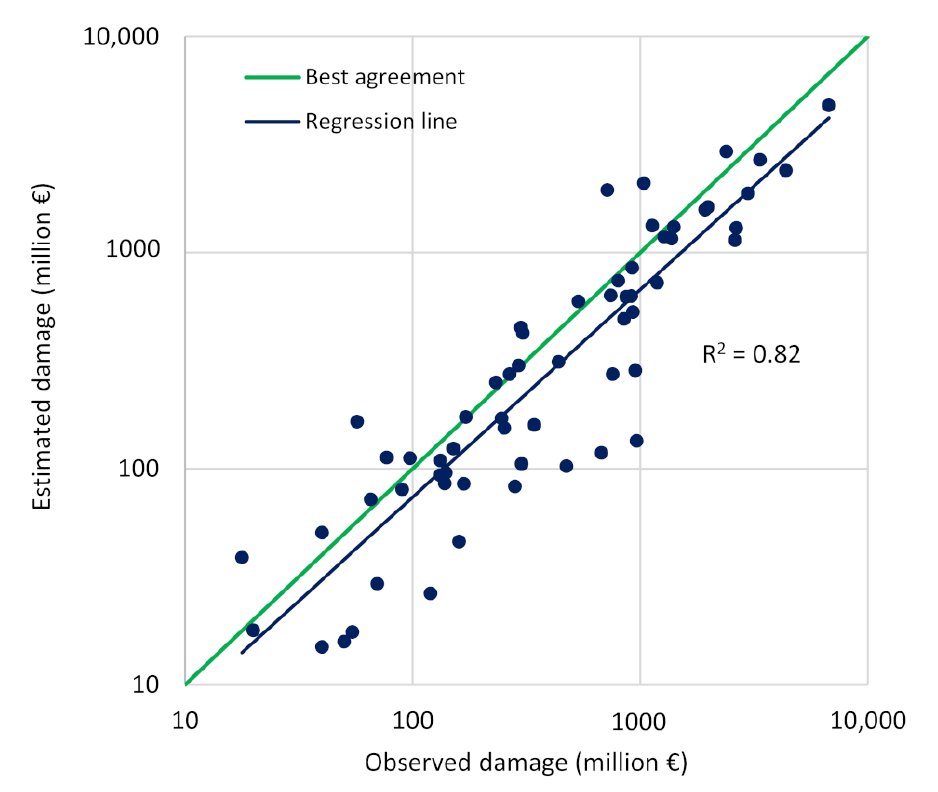
Figure 7. Estimated vs. observed values for the validation dataset. The green line represents the best fit. The blue line represents the data regression line, and its R 2 indicates good data alignment.